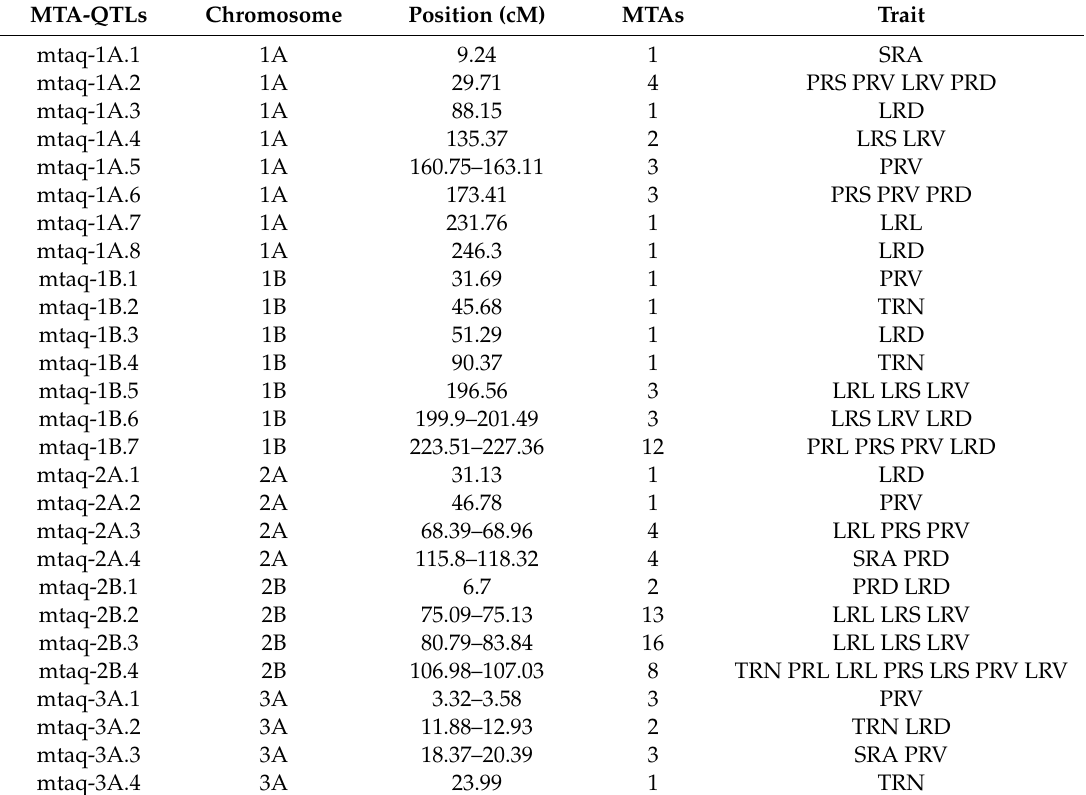
Figure 4. MTA-QTL map. MTA-QTLs are indicated in bold on the left side of the chromosome and traits involved in each MTA-QTL are on the right side. The rule on the left indicates genetic distance in cM. TRN, total root number. SRA, seminal root angle. PRL, primary root length. LRL, total lateral root length. PRS, primary root surface. LRS, total lateral root surface. PRV, primary root volume. LRV, total lateral root volume. PRD, primary root diameter. LRD, mean lateral root diameter. Table 3. MTA-QTLS.